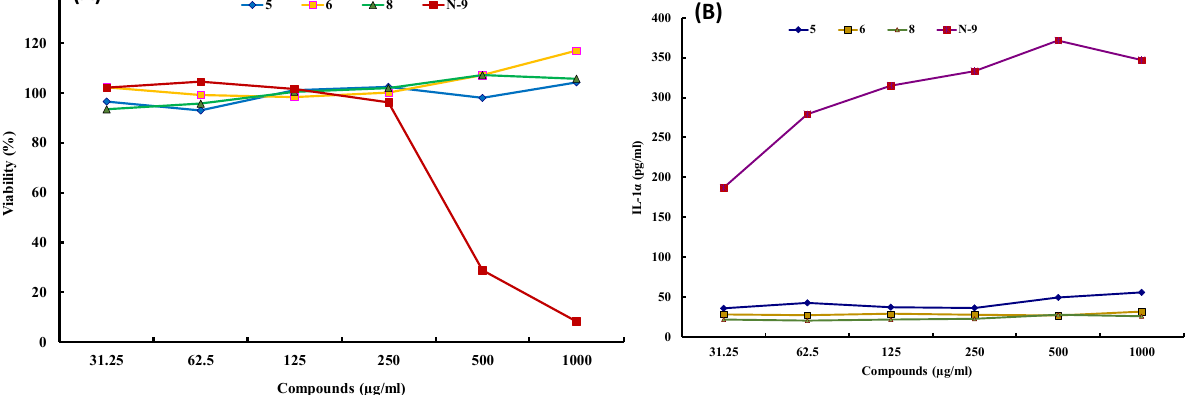
Figure 2. ( A ) Dose–response curves of the vaginal cytotoxicity in VK-2 cells (MTS assay) for 5 , 6 , 8 , and N-9 after 6 h incubations. ( B ) Proinflammatory cytokine (IL-1 α ) production in the VK-2 cells (ELISA) after a 6 h incubation in the presence of 5 , 6 , 8 , and N-9.